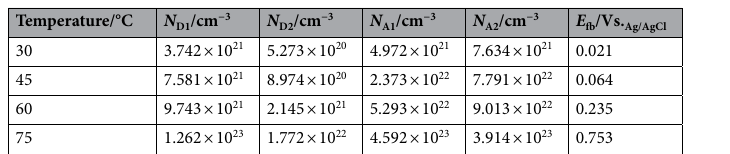
Table 5. Fitting results of Mott Schottky curve (donor concentration N D and acceptor concentration N A ).